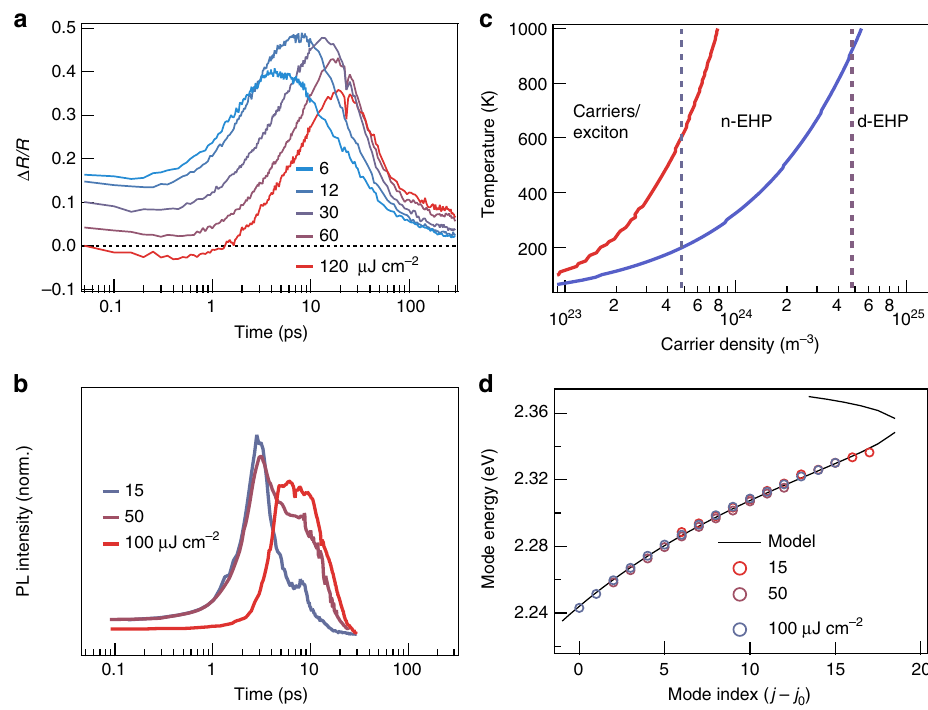
Fig. 5 Carrier cooling, phase transitions, and mode energies. a Time evolution of the positive feature in the transient re fl ectance representing the carrier cooling dynamics as various pumping powers. b Integrated lasing intensity from the plots in Fig. 3, demonstrating the connection with the time scales for carrier cooling in panel ( a ). c Phase diagram showing the temperature and carrier densities at which the Mott densities and population inversions lie, leading to the three electronic phase regimes: thermodynamic population of carriers and excitons, nondegenerate electron hole plasma (n-EHP), degenerate electron hole plasma (d-EHP). d Experimentally determined modes (extrapolated to the lasing threshold) shown along the mode pro fi le calculated using a single Lorentzian oscillator for the dielectric function (see Supplementary Note